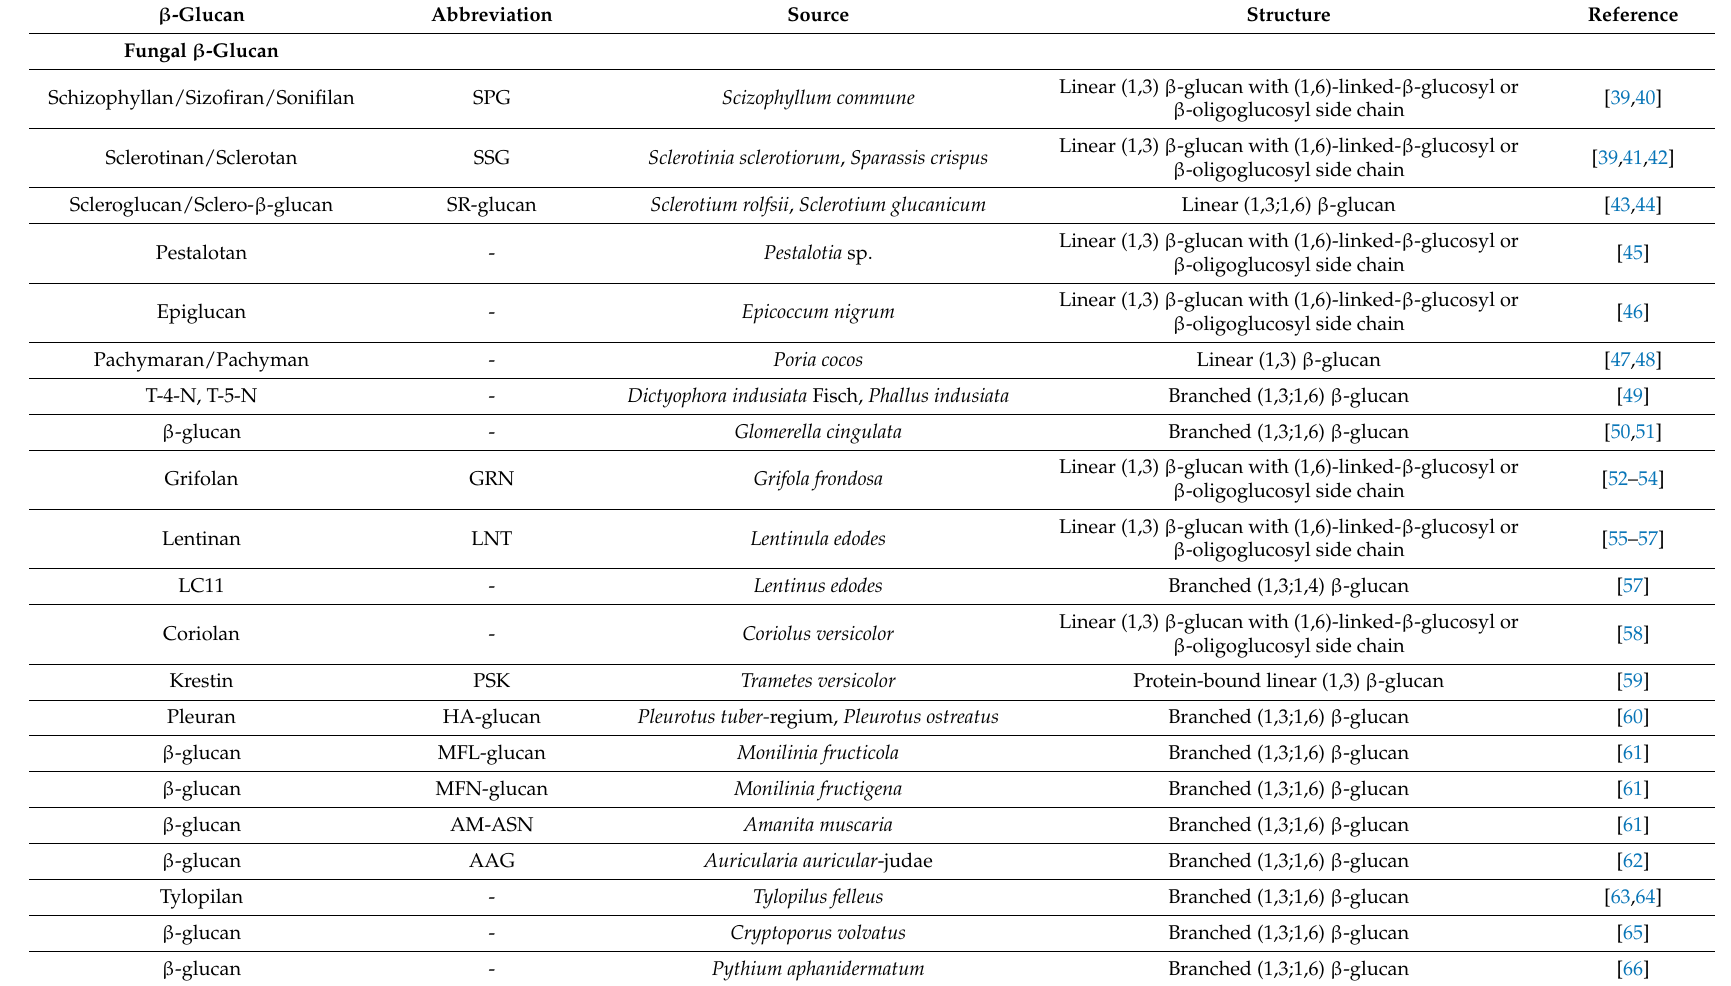
Table 1. Common bioactive β -glucans, their structure, and